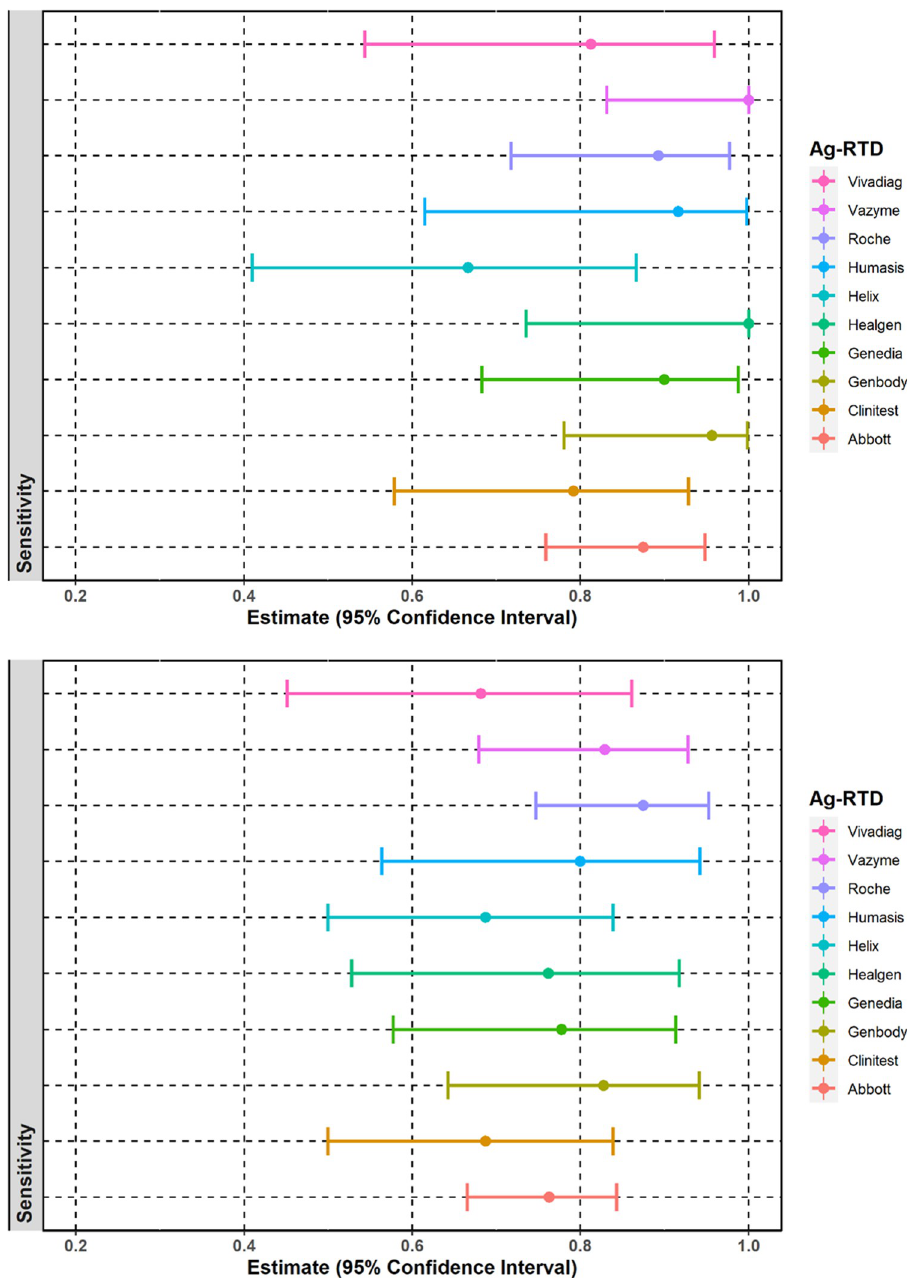
Fig 5. Sensitivity of the ten different Ag-RTDs A. strongly positive samples (Ct � 25), B. positive samples with Ct �